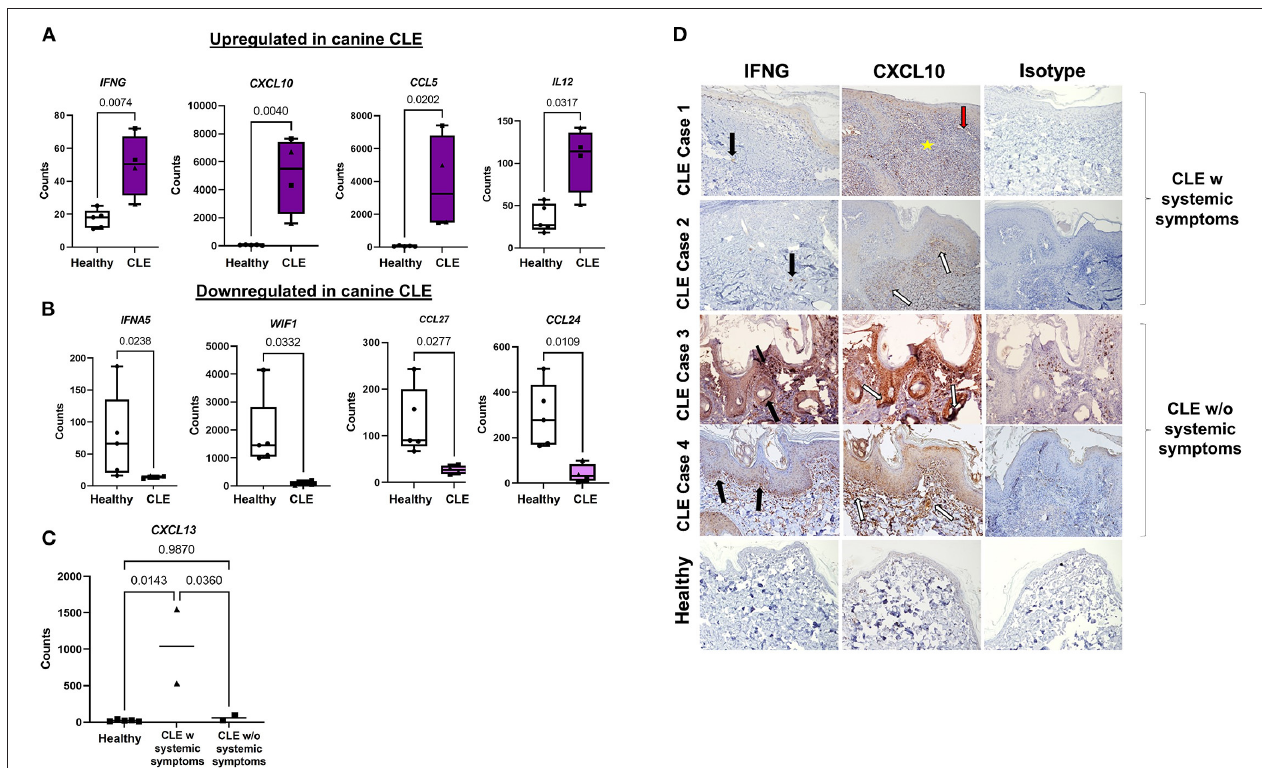
FIGURE 2 | Gene signatures and immunohistochemical features of complex CLE cases. Box plots of (A) significantly upregulated and (B) downregulated genes in cases vs. controls. (C) Examination of CXCL13 expression in CLE with or without systemic symptoms. (D) Immunohistochemistry demonstrates the origin of IFN γ and CXCL10 expression in CLE skin vs. control skin and isotype control. IFN γ (black arrows) and CXCL10 (white arrows) secretion in CLE + systemic symptoms are derived from the immune infiltrate in CLE case 1 and 2, in contrast to keratinocytes at the basal epidermis in CLE case 3 and 4 (10x objective). Perivascular (red arrow-blood vessel) lymphocyte infiltration (yellow star) (w, with, triangle symbols; w/o, without, square symbols).